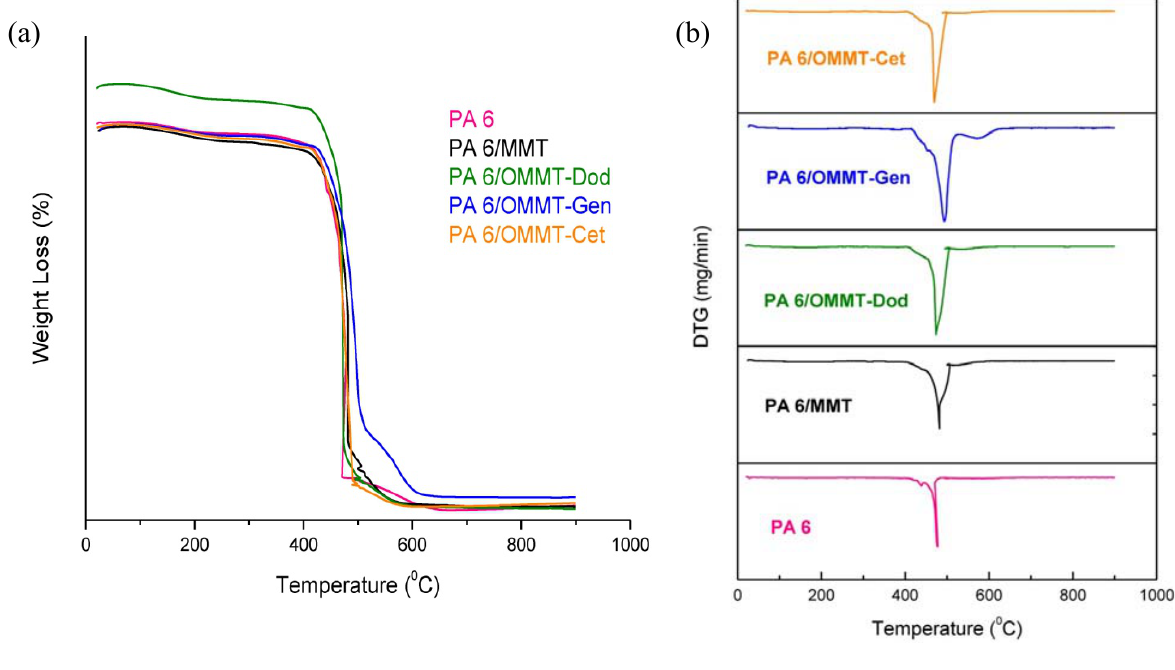
Figure 7. TG ( a ) and DTG ( b ) curves of polyamide 6 and its